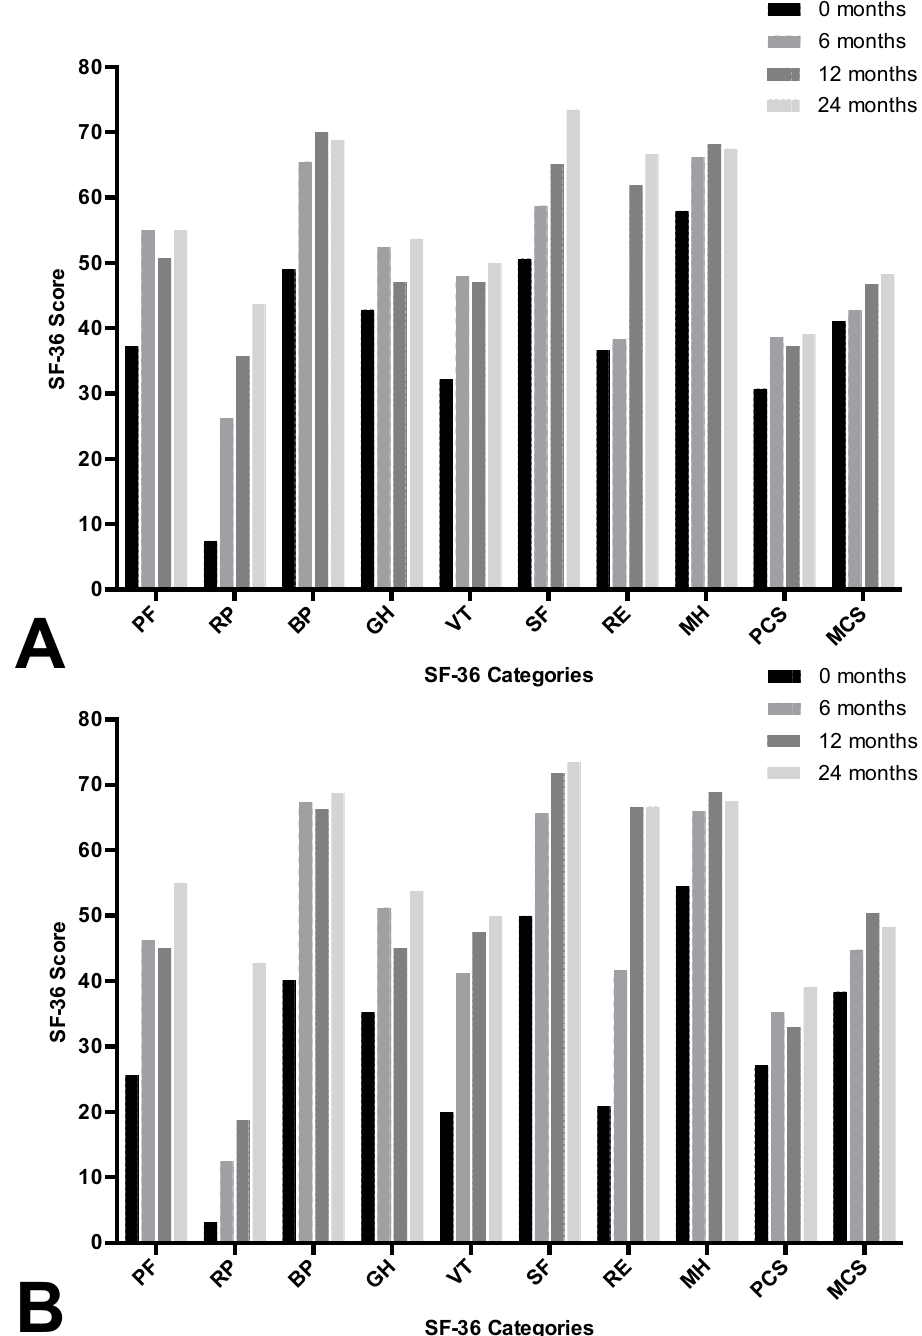
Figure 2. Quality of life determined by the SF–36. Quality of life improves in eight domains and in two summary scales for the total cohort ( A ) and in a subgroup excluding patients who were weaned off PN ( B ). Data presented as mean ± standard deviation. PF, Physical Functioning; RP, Role-physical; BP, Bodily Pain; GH, General Health; VT, Vitality; SF, Social Functioning; SF-36, Short Form 36; RE, Role-emotional; MH, Mental Health; PCS, Physical Component Summary; MCS, Mental Component Summary.